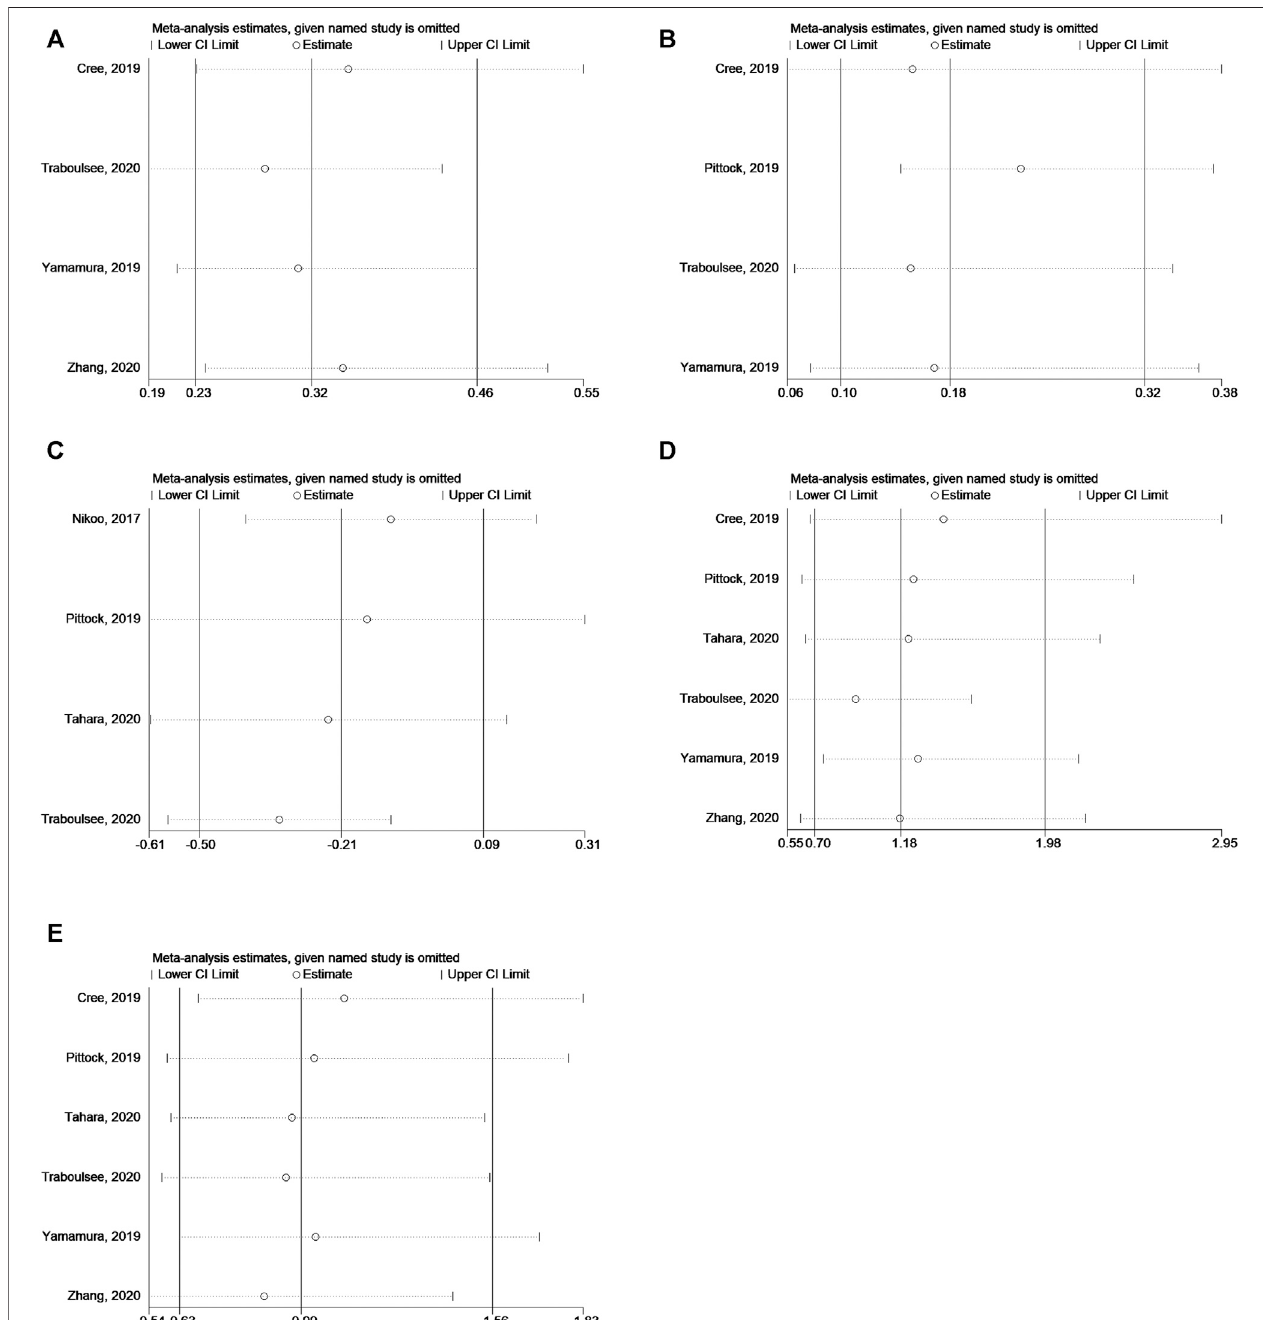
FIGURE 8 |(A) Sensitivity analysis for HR ofrelapse in NMOSD patients. (B) Sensitivity analysis for HR of relapse in NMOSD patientswith AQP4-IgG-seropositive. (C) Sensitivity analysis for EDSS score change in NMOSD patients. (D) Sensitivity analysis for odds of AEs. (E) Sensitivity analysis for odds of SAEs.